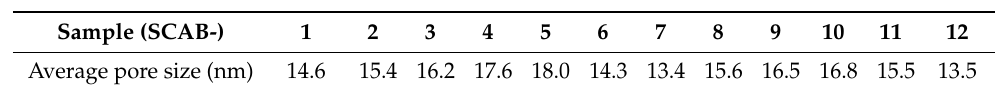
Table 2. The average desorption pore size of the